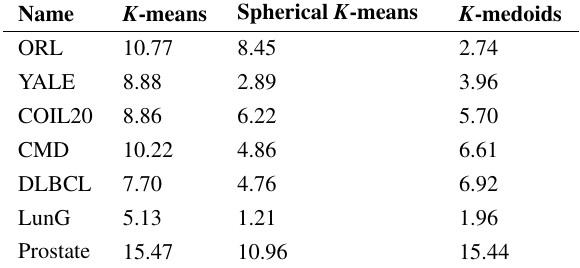
Table 5 The comparison of the run times on the actual data